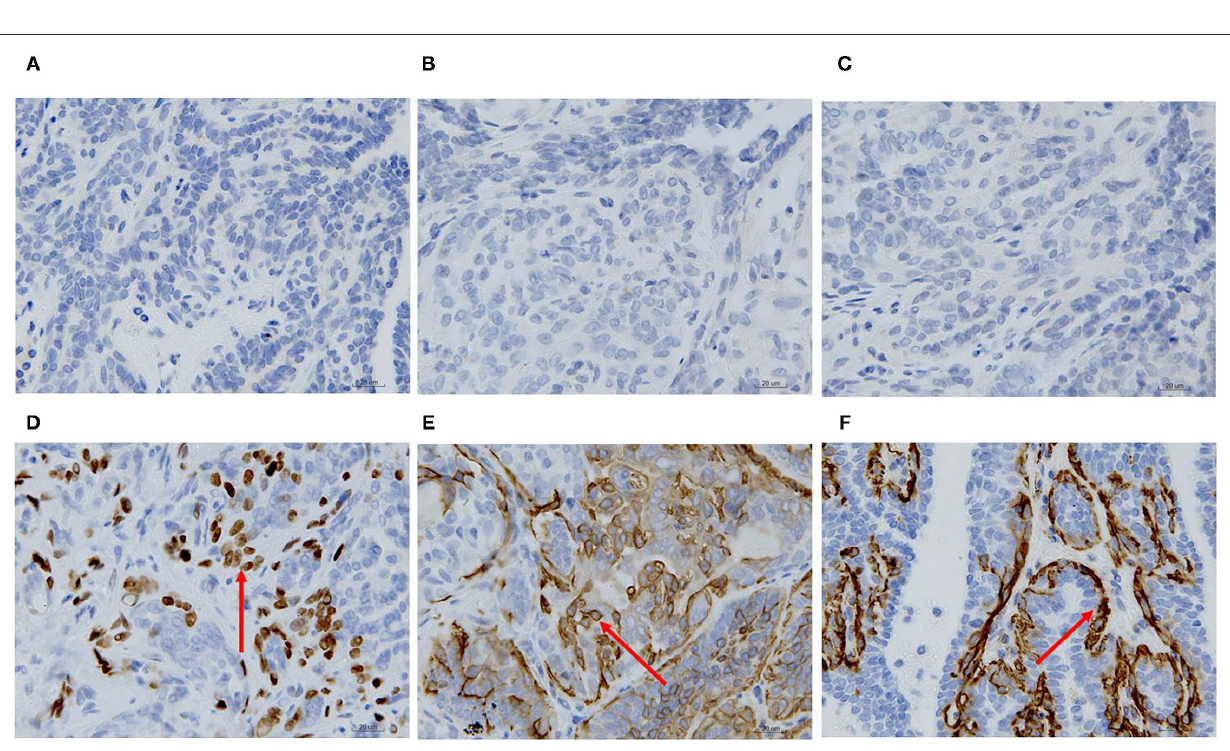
showed a positive expression rate of 12.89%, CK5/6 showed a positive expression rate of 29.45%, and α -SMA showed a positive expression rate of 23.17%. The neoplasm exhibited characteristics of a triple-negative canine mammary